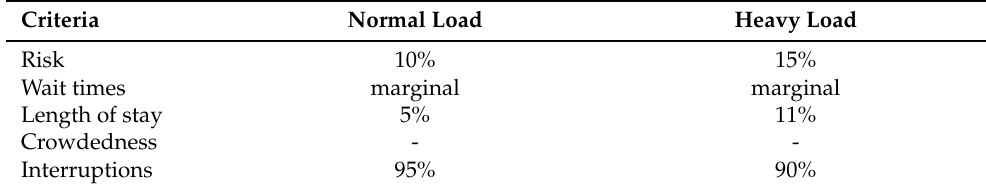
Table 3. Marginal improvement of the LBA approach compared to FCFSwU.